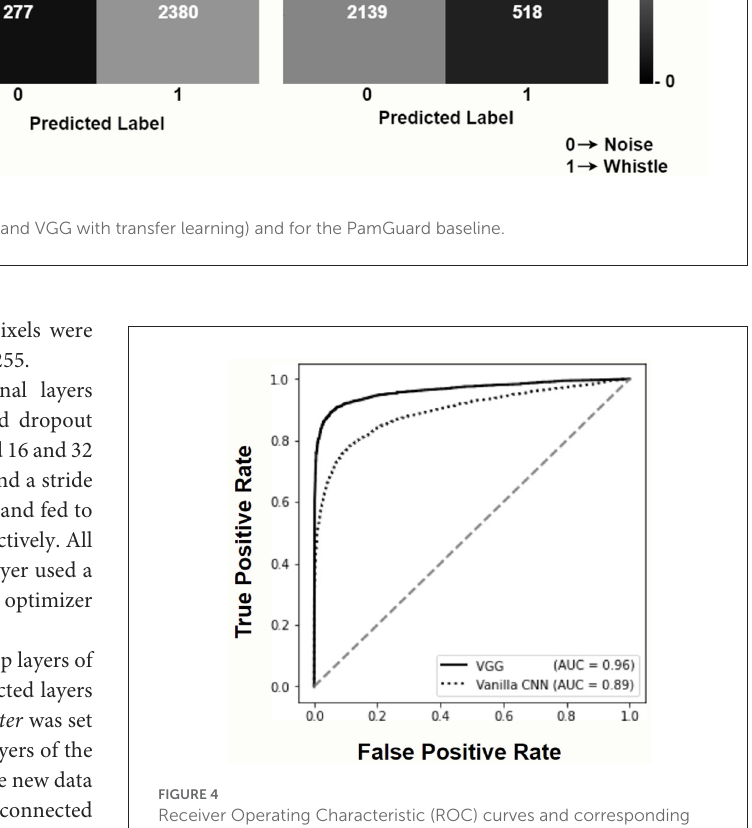
FIGURE4 Receiver Operating Characteristic (ROC) curves and corresponding Area Under the Curve (AUC) values for both deep learning